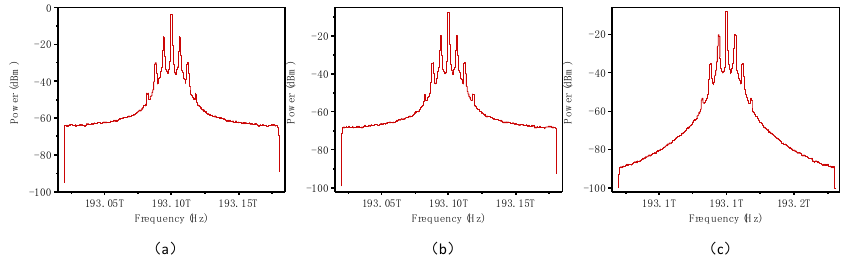
Fig.3. (a) The optical spectrum before transmission; (b) The optical spectrum after transmission; (c) The optical spectrum after splitting and filtering (the first